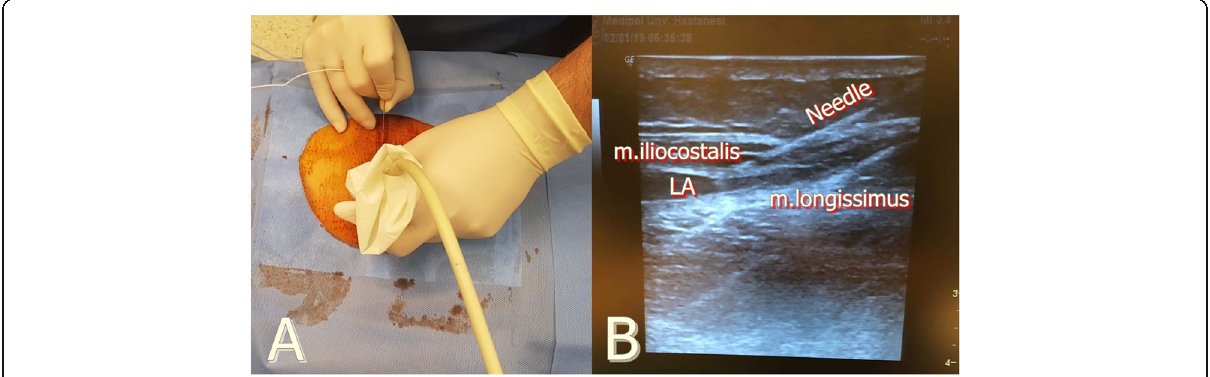
Fig. 2 a Ultrasound and patient setup for block preparation. b Sonographic anatomy and spread of local